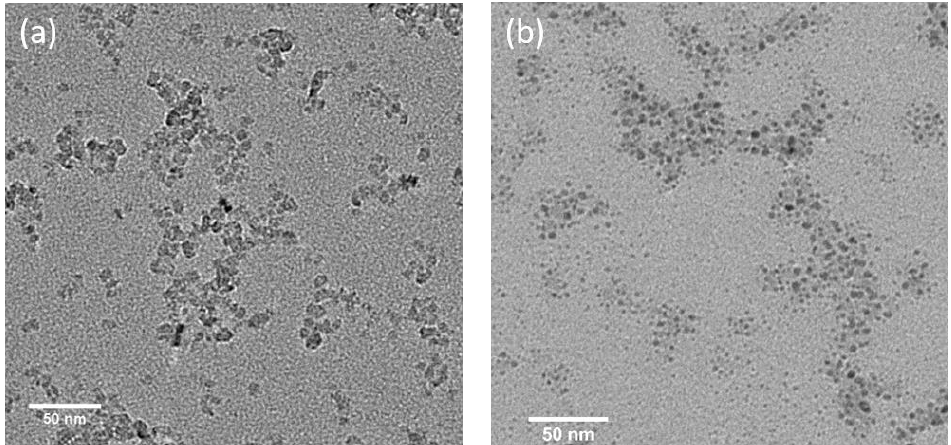
Figure 1. TEM images of ( a ) the as prepared BCNO nanoparticles and ( b ) PEG@BCNO after ligand exchange.